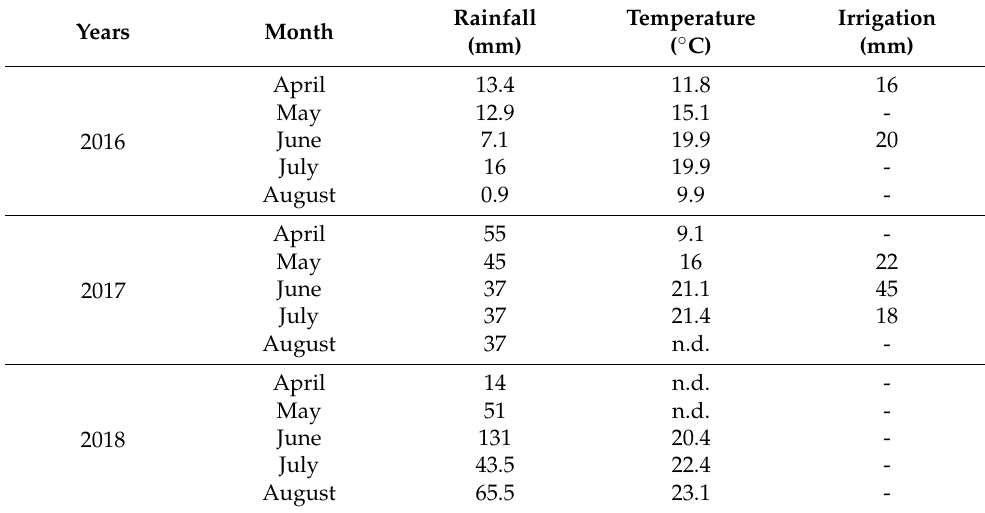
Table 2. Mean monthly precipitation (mm), irrigation, and temperature ( ◦ C) at the experimental site in 2016, 2017, and 2018 (Babatpuszta,